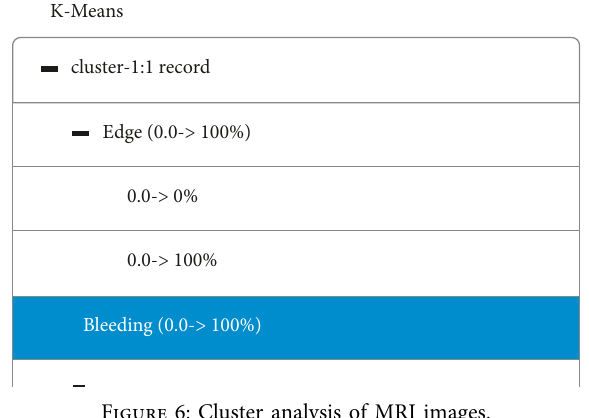
Figure 6: Cluster analysis of MRI images. Table 6: The input stream for rule